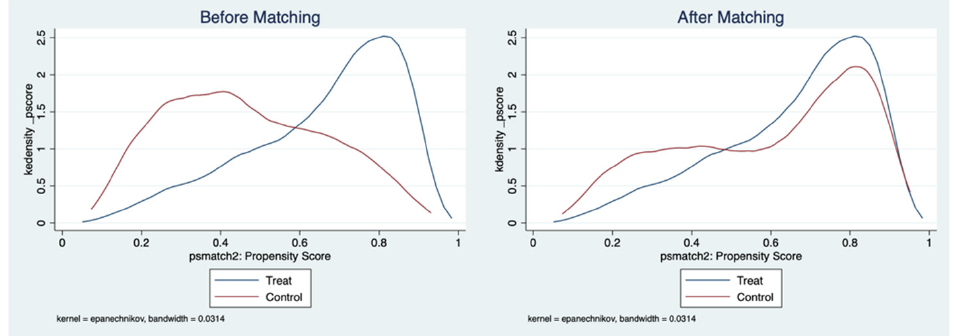
Figure 1. Kernel density distribution.